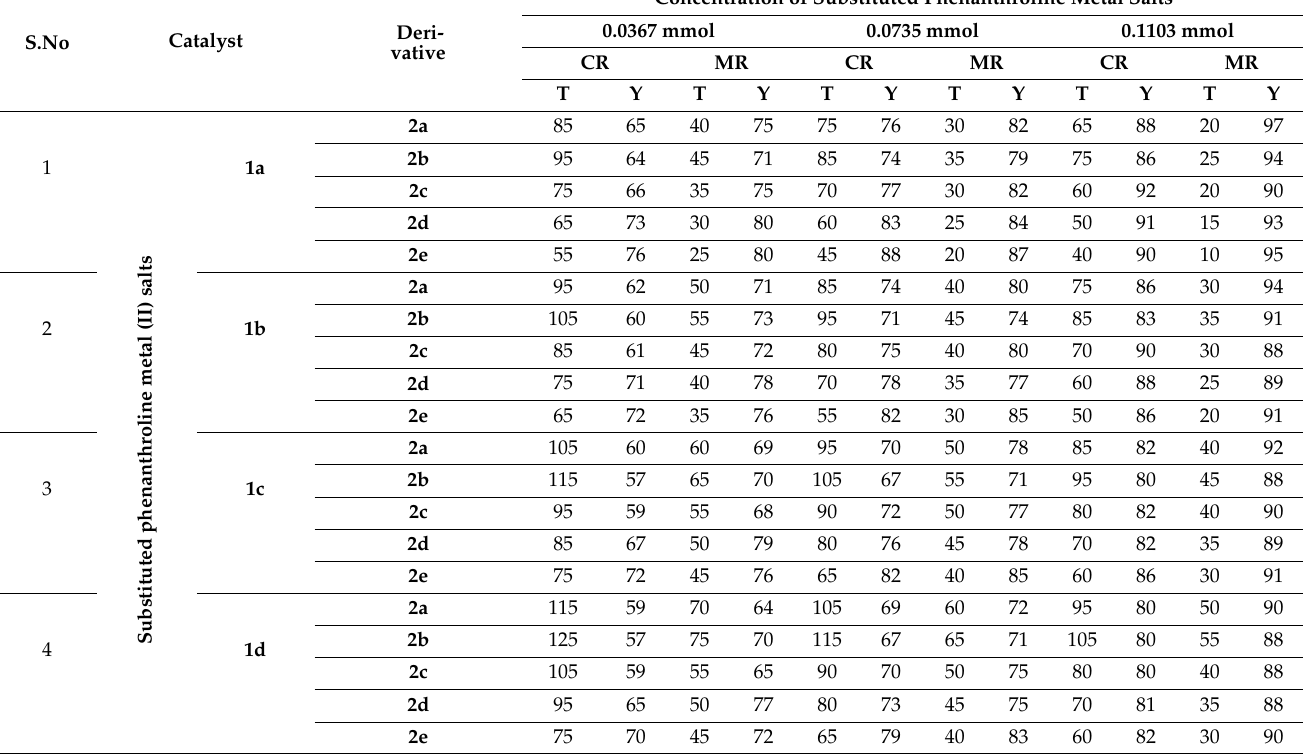
Table 4. Synthesis of β-Amino carbonyl derivatives assisted by various concentrations of metal com- plex 1 ( a – d ).